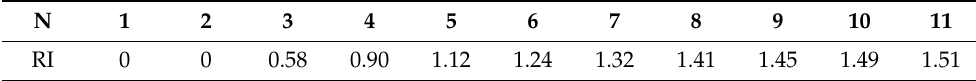
Table 2. Scale of preference.